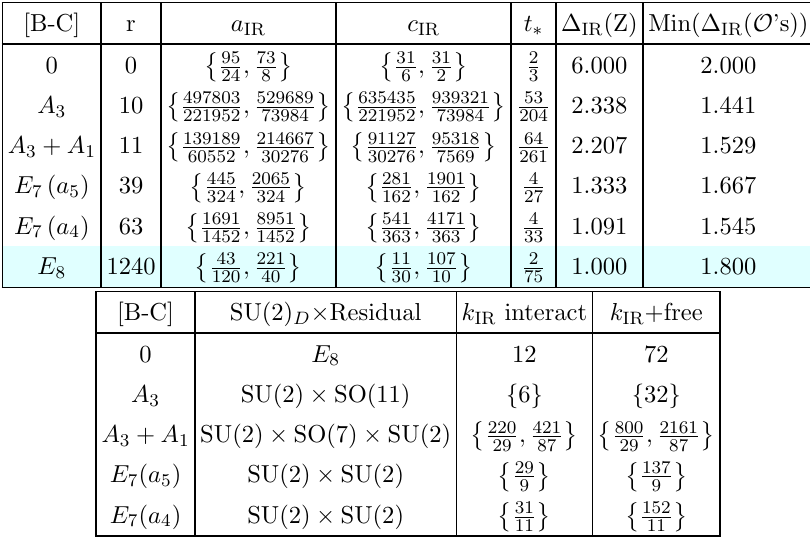
Table 16. Flipper (cid:12)eld deformations of the Minahan-Nemeschansky theory with E 8 (cid:13)avor, only rational values. The top table has the central charges a IR and c IR as well as scaling dimensions while the table below contains the information about the (cid:13)avor central charges. The cyan highlighted entry aligns with the H 0 Argyres-Douglas theory, as (cid:12)rst noted in [17]. The other rational central charges are also in agreement with